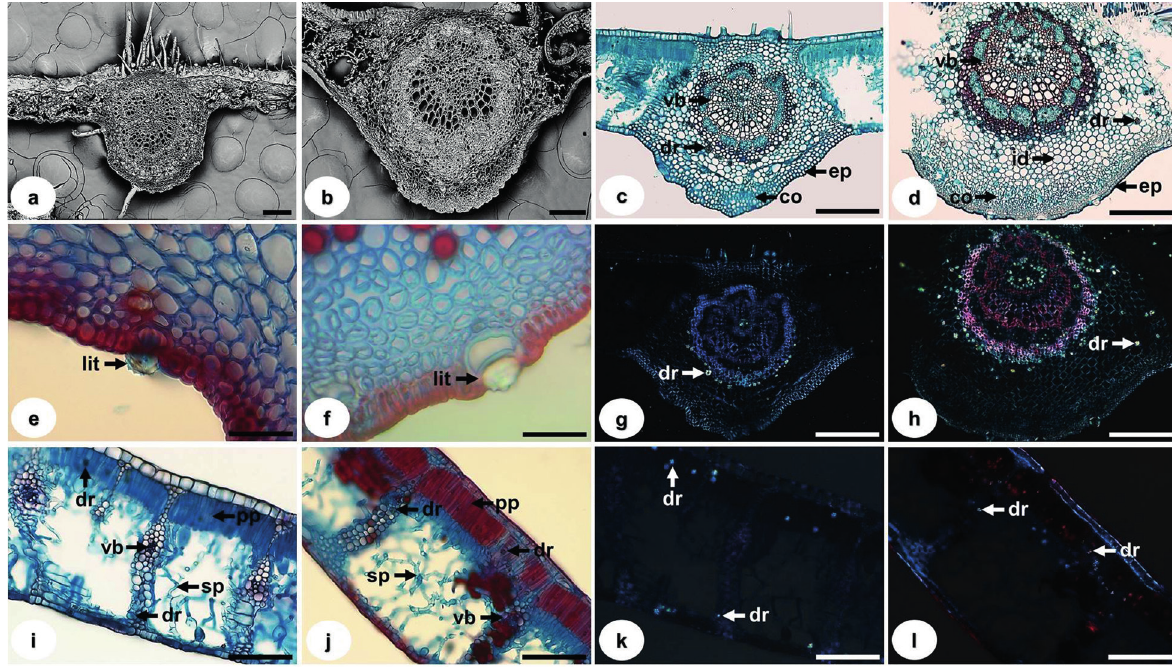
Figure 3 - Cross-sections of the leaf blades of Artocarpus altilis and Artocapus heterophyllus . a , c , e , g , i and k : A. altilis ; b , d , f , h , j and l : A. heterophyllus ; a and b : scanning electron microscopy; c , d , e , f , i and j : optical microscopy; g , h , k and l = polarized light microscopy. Abbreviations: co = collenchyma; dr = druse; ep = epidermis; id = idioblast; lit = lithocyst; pp = palisade parenchyma; sp = spongy parenchyma; vb = vascular bundle. Bars: c , g , i , j , k and l = 100 µm; a , b , d and h = 200 µm; e and f = 50